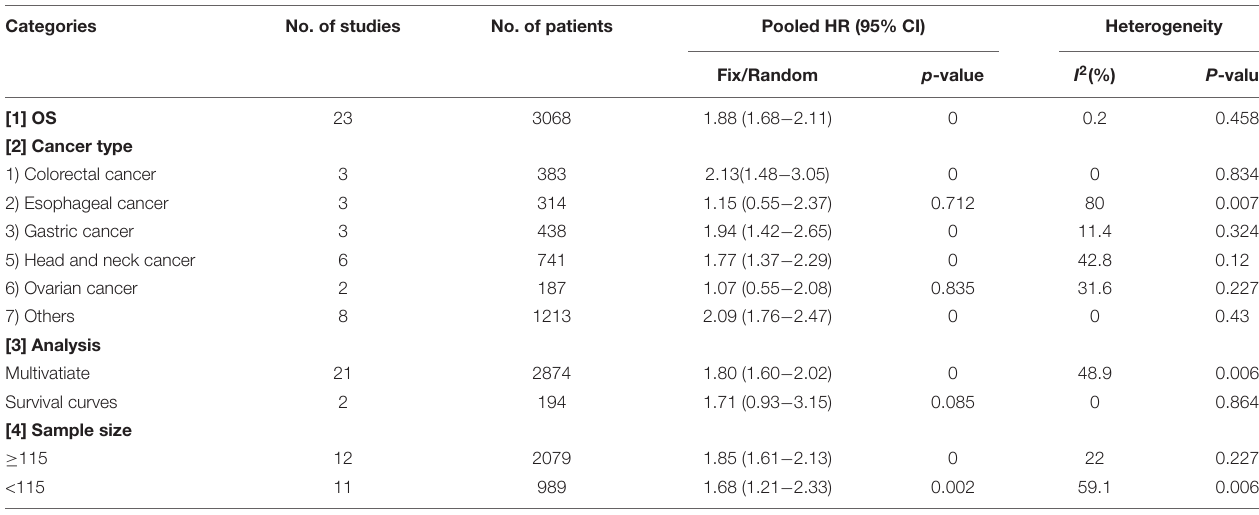
TABLE 2 | Subgroup analyses of pooled HR for OS.